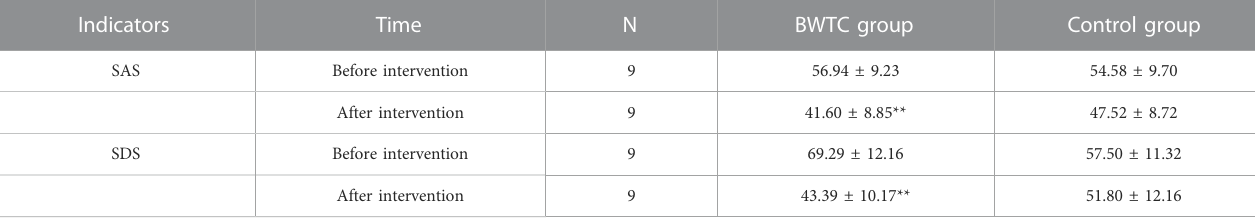
TABLE 3 Comparison of the SAS and SDS scores of the two groups ( _x ± s).